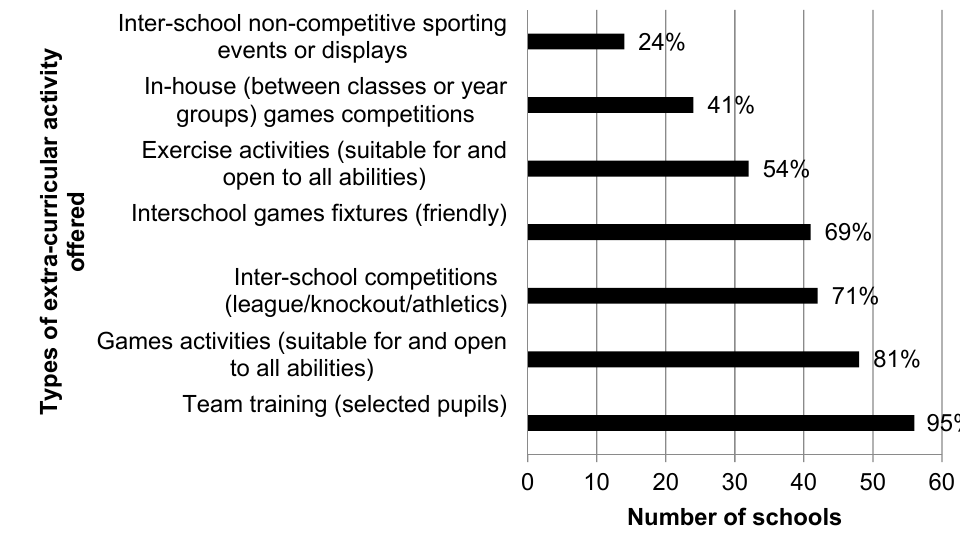
Figure 1. Extra-curricular activities offered within schools on a regular basis. Table 4. Number (%) of responding schools who have established links with outside agencies to promote physical activity outside of timetabled physical education.